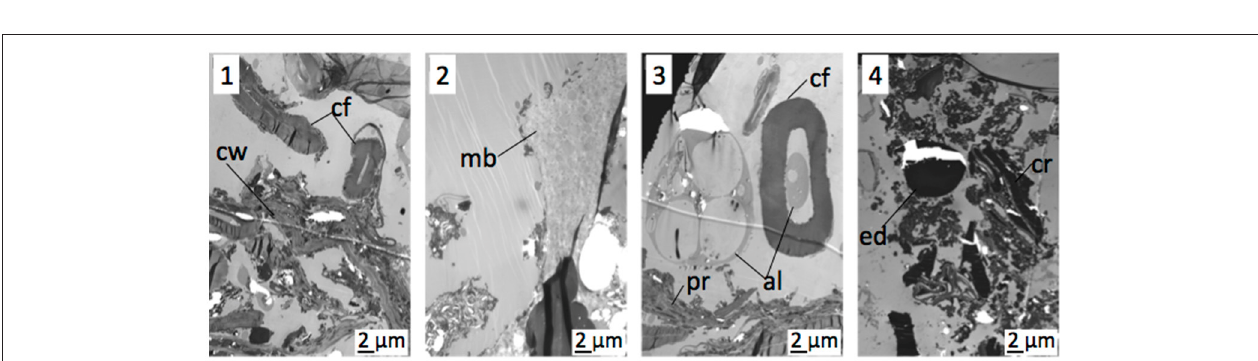
FIGURE 2 | TEM views of MPs in compost–membrane structured (1, 5, 7) , alveolar structured (2, 3) and electron-dense (4) and EDX spectra (spectrum 6 and 8 corresponding, respectively, to arrows in views 5 and 7) . m, mineral; mb, alveolar membrane; r, resin surrounding the membrane.